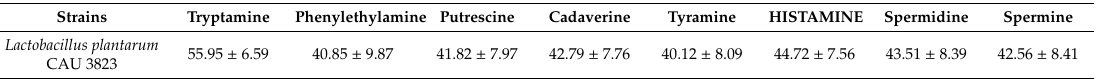
Table 1. Percentage (%) of degradation of the biogenic amines by Lactobacillus plantarum CAU 3823 from Chinese rice wine a